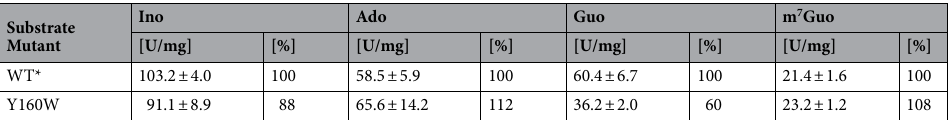
Table 1. Enzymatic specific activity of the Y160W PNP mutant vs. natural substrates (inosine, adenosine and guanosine) and vs. 7-methylguanosine compared with the similar data for the WT E. coli PNP. Data were obtained at pH 7.0, in 50 mM Hepes buffer, 25 °C, with 50 mM phosphate using spectrophotometric methods described in “Methods” section. *From 13 .